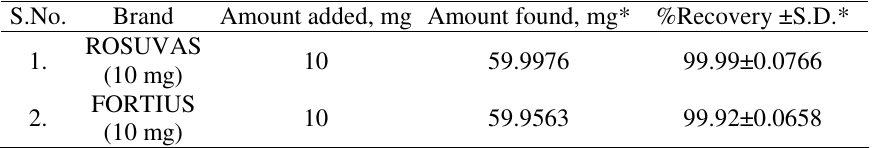
Table 3. Recovery studies of ROSU